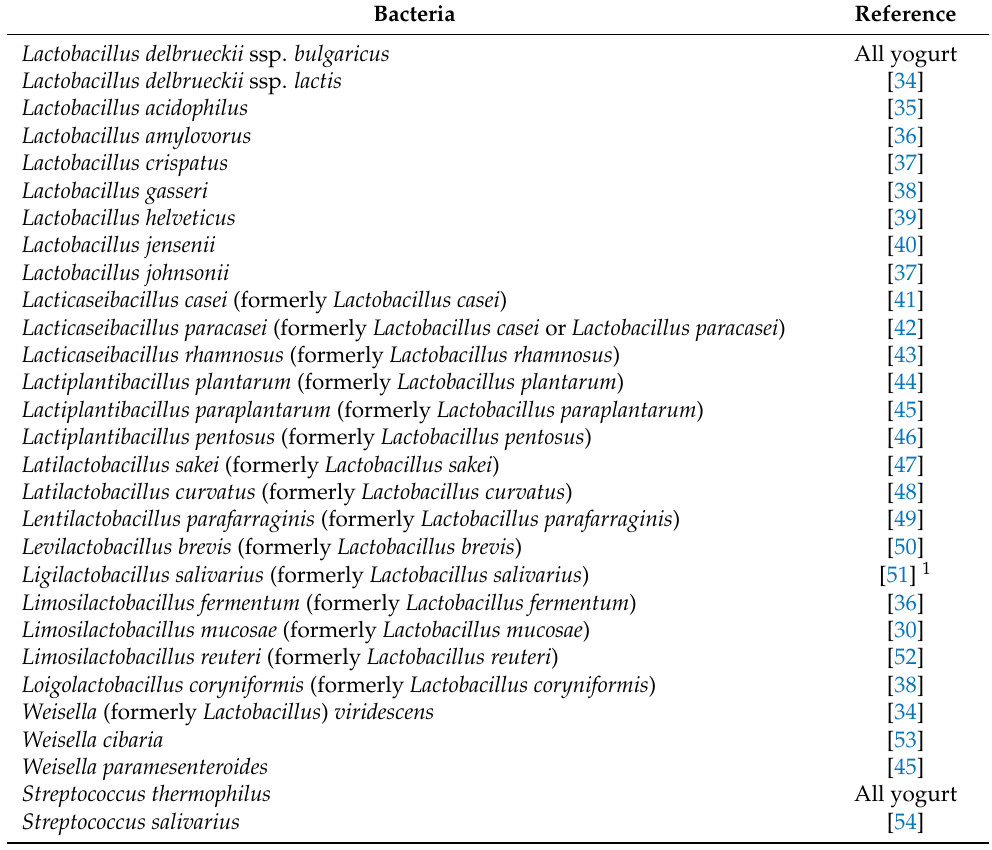
Table 1. Bacteria, including postbiotics, and yeast with claimed probiotic properties, potential probiotic properties, or potential therapeutic application that have been incorporated into or isolated from yogurt or yogurt-related